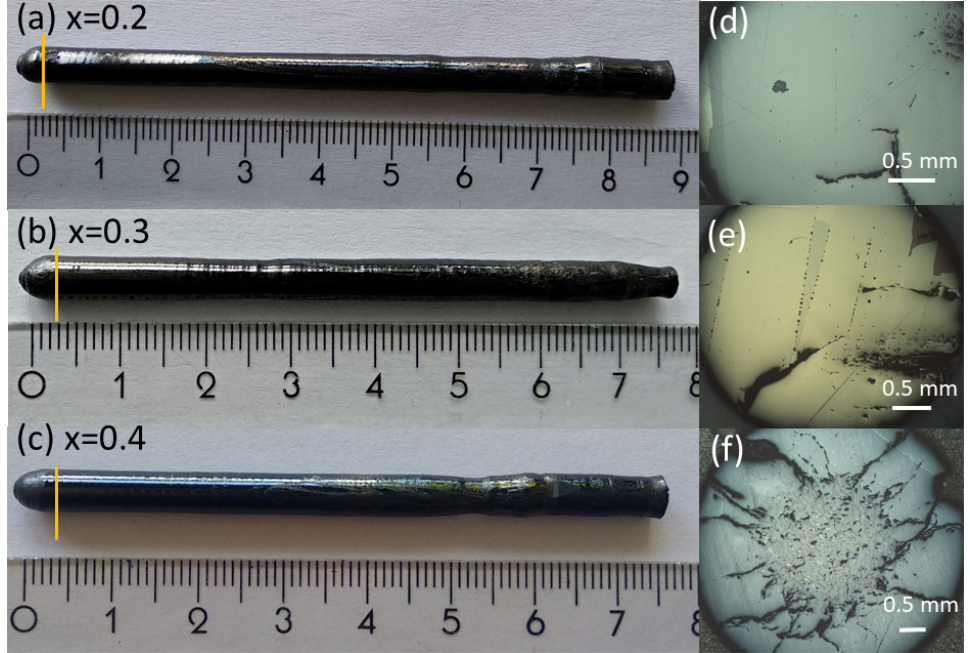
Figure 6. Grown crystals of nominal composition La 1.81 − x Sr 0.19 Eu x CuO 4 , x = 0.2 ( a ), x = 0.3 ( b ) and x = 0.4 ( c ) and their corresponding cross-sections ( d – f ).